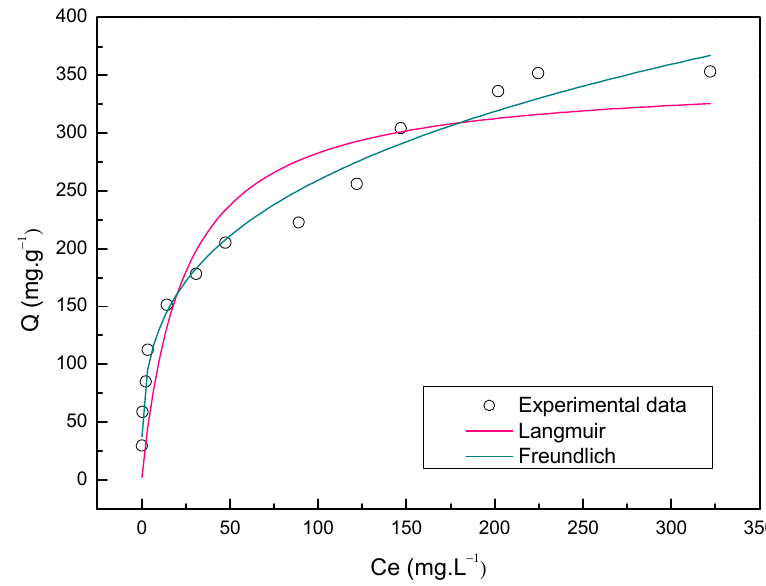
Figure 8. Equilibrium isotherms of Nimesulide adsorption onto ACOP.